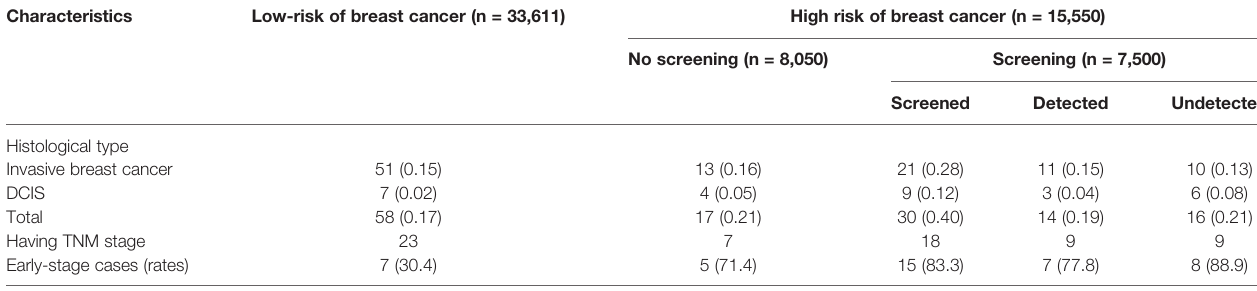
TABLE 3 | Characteristics of detected and undetected breast cancer, n (%).